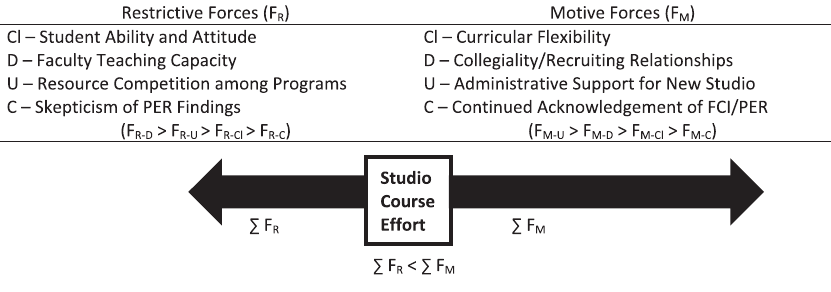
FIG. 4. Free body diagram for stage 2: Expansion of the studio physics program (Cl—classroom; D—department; U—university;